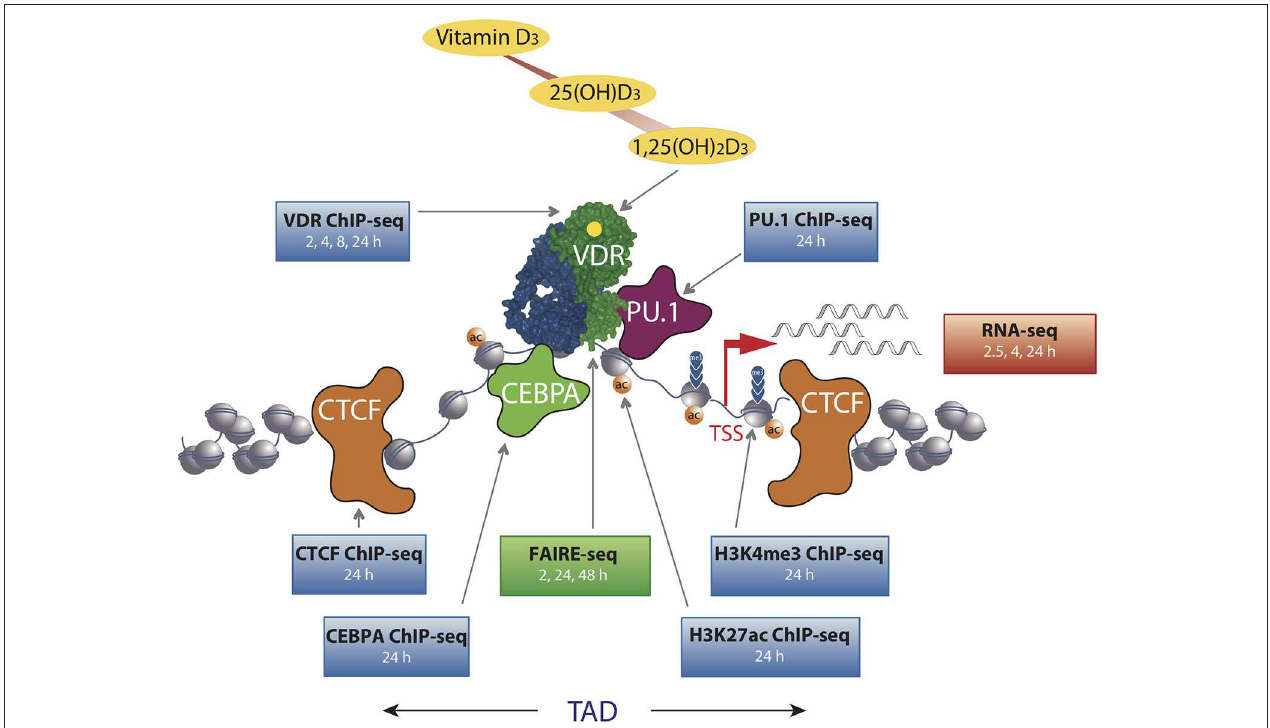
FIGURE 1 | The chromatin model of vitamin D signaling. The model was defined by epigenome- and transcriptome-wide data obtained in THP-1 cells. CTCF proteins define left and right TAD borders, in which vitamin D target genes (red arrow, measured by RNA-seq) are activated by VDR [activated by 1,25(OH) 2 D 3 ] binding to enhancer regions. The pioneer transcription factors CEBP α and PU.1 help VDR in binding to accessible genomic DNA (measured by FAIRE-seq). This paralleled with changes in markers of active TSS regions (H3K4me3) and active chromatin (H3K27ac). The genome-wide binding of VDR, CTCF, PU.1, CEBP α , and histone markers were determined by ChIP-seq in three biological repeats. The time of 1,25(OH) 2 D 3 stimulation is indicated for each